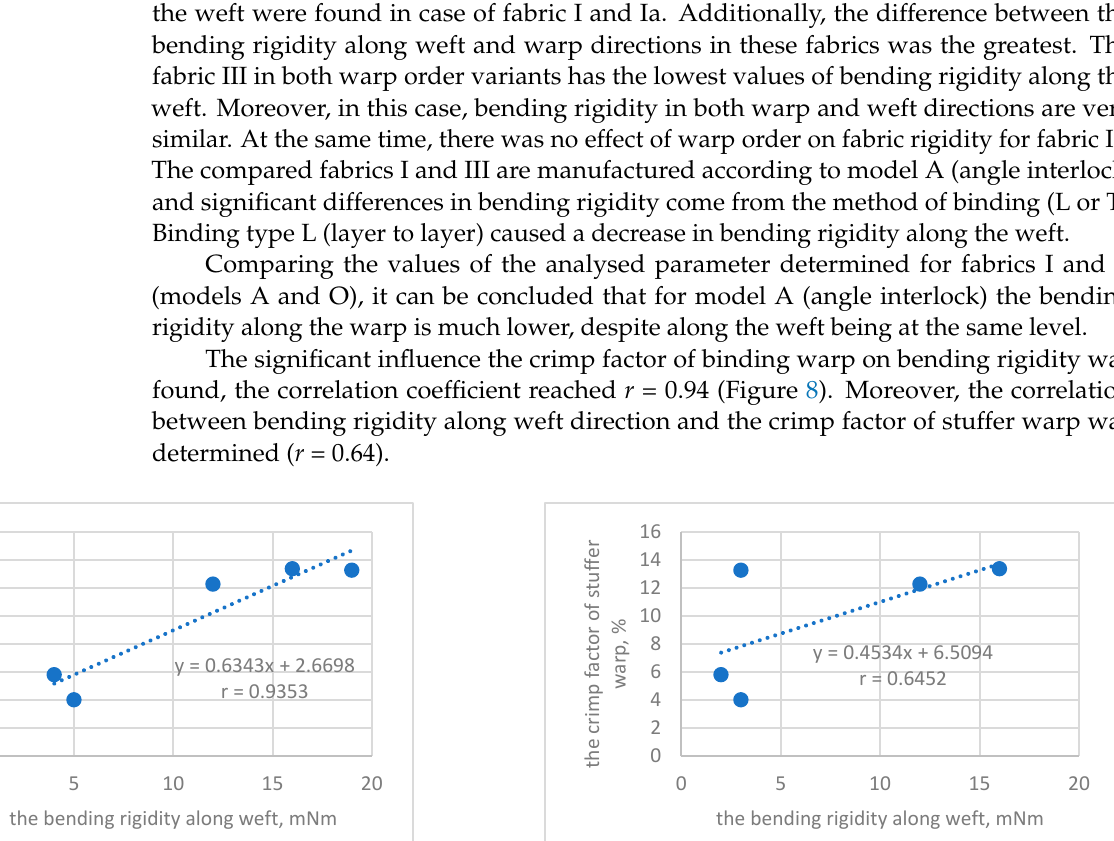
Table 5. Results of bending rigidity test for MLW fabrics.